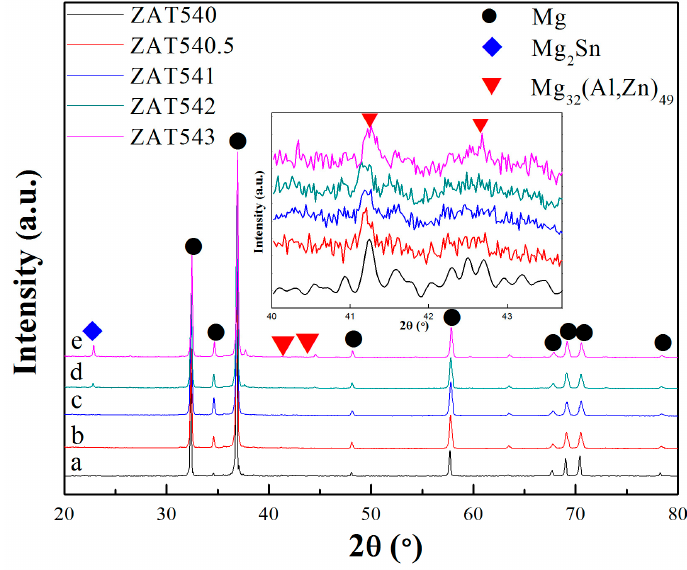
Figure 2. X-ray diffraction (XRD) patterns of extruded Mg–5Zn–4Al–xSn alloys: ( a ) ZAT540, ( b ) ZAT540.5, ( c ) ZAT541, ( d ) ZAT542, and ( e ) ZAT543.